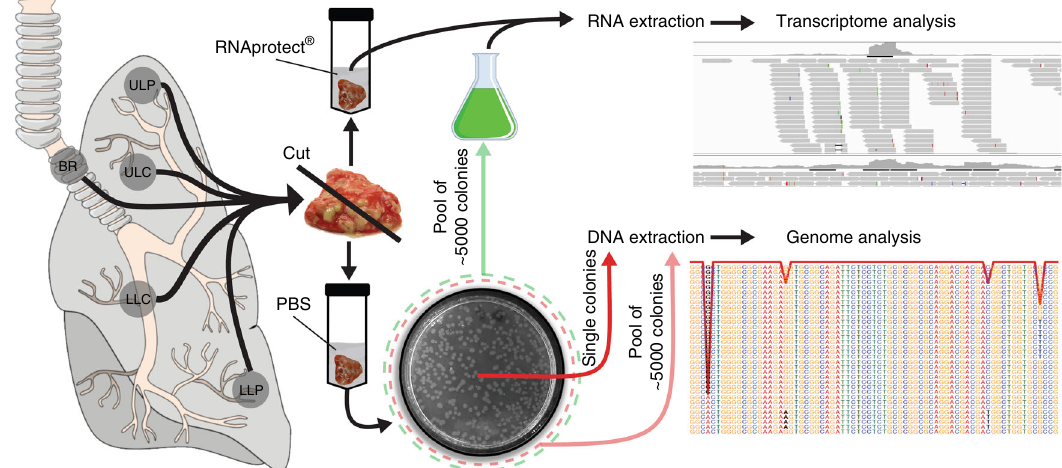
Fig. 1 Collection of regional P . aeruginosa populations from an explanted cystic fi brosis (CF) lung. Tissue from fi ve different compartments of an explanted CF lung was sampled (main bronchus = BR; upper lobe central = ULC and peripheral = ULP; lower lobe central = LLC and peripheral = LLP). One part of the tissue was homogenized in the presence of RNAprotect for ex vivo RNA-sequencing (RNASeq) and the other part was streaked on selective agar plates to recover single P. aeruginosa isolates (after homogenization in phosphate-buffered saline (PBS)). Pools of ~5000 single colonies (green dashed circle) from the fi ve sub-compartments were cultivated in rich medium conditions to record in vitro transcriptome pro fi les by RNASeq. DNA was extracted from overnight cultures of single isolates and from cell pellets of pools of agar grown colonies (red dashed